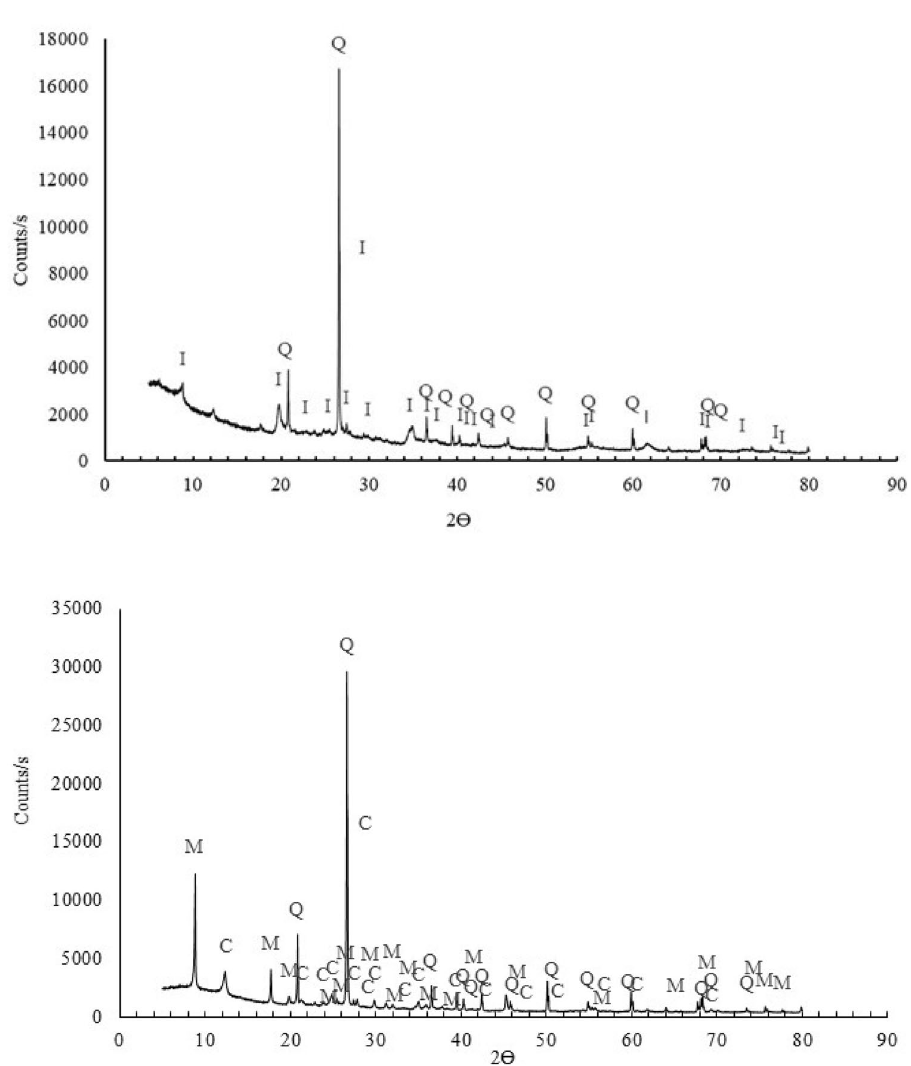
Fig. 3 Red clay mineral com- position obtained by X-ray diffraction (Q-quartz; I-Ilite)